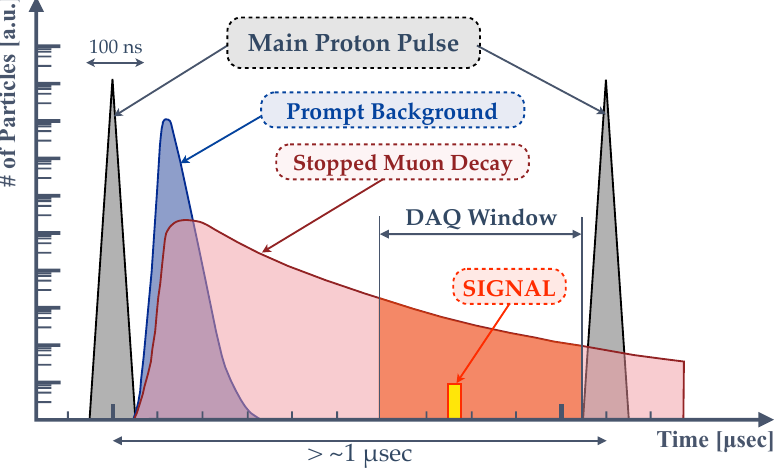
Figure 2. Time relation among the proton beam pulses, prompt background, stopped muon decay, and a signal event in the data-taking